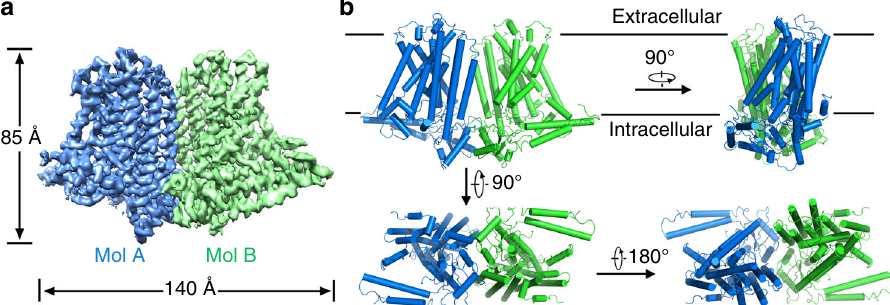
Fig. 1 Overall dimeric structure of AtOSCA1.2. a An overview of the EM density at 3.68 Å resolution. Densities for the two AtOSCA1.2 molecules in the dimer structure are coloured blue and green, respectively. b The cartoon representation of the AtOSCA1.2 structure is shown in four perpendicular views. The two AtOSCA1.2 monomers are coloured blue and green, respectively. Each monomer contains 11 transmembrane helices. All structure fi gures